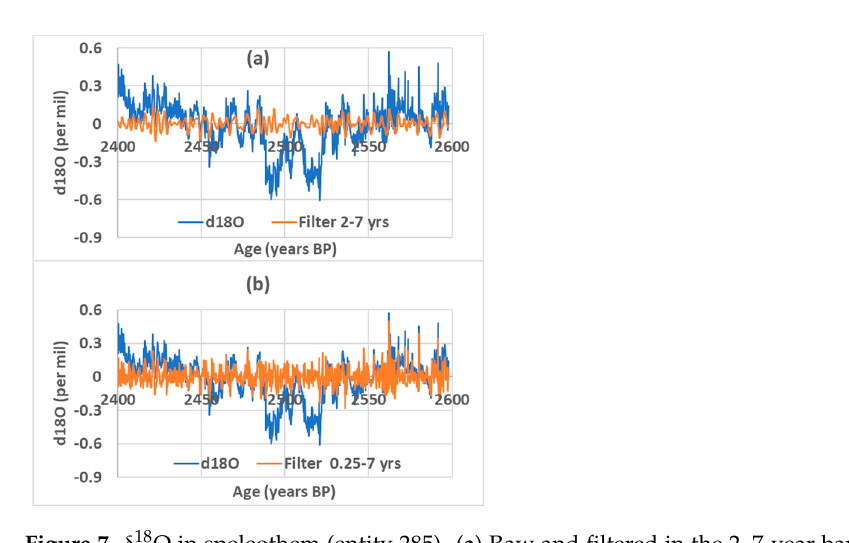
Figure 7. δ 18 O in speleothem (entity 285). ( a ) Raw and filtered in the 2–7 ‐ year band; ( b ) raw and filtered in the 0.25–7 ‐ year band .